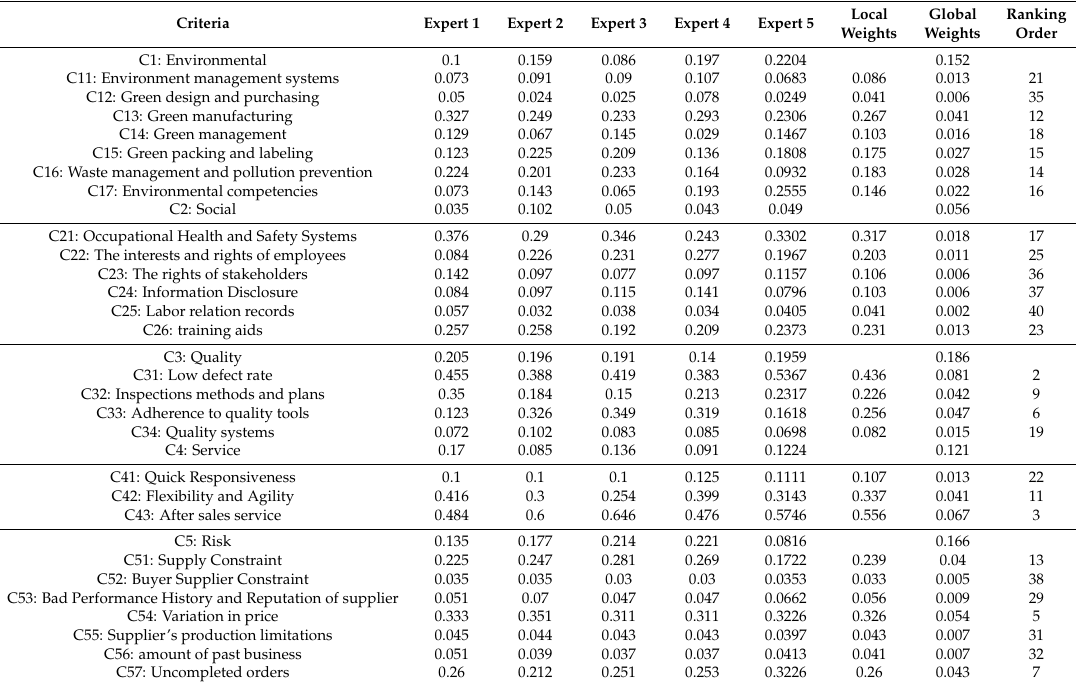
Table 3. The local and global